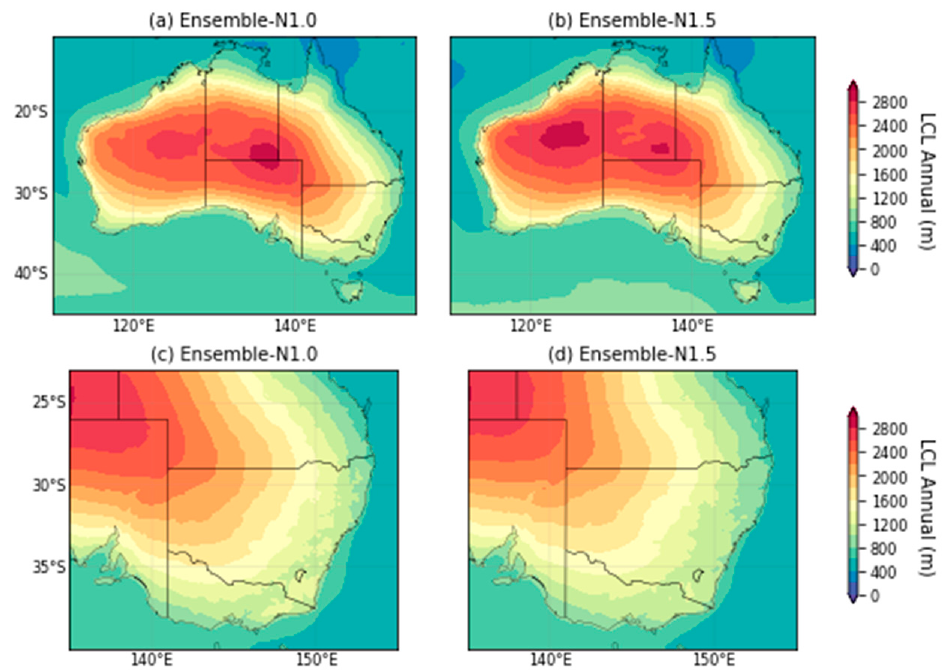
Figure A1. Climatology of the annual LCL from the ( a ) N1.0 and ( b ) N1.5 ensemble mean in the CORDEX domain (d01). ( c , d ) Same as ( a , b ) except for distributions in the NARCliM domain (d02). Unit: m.